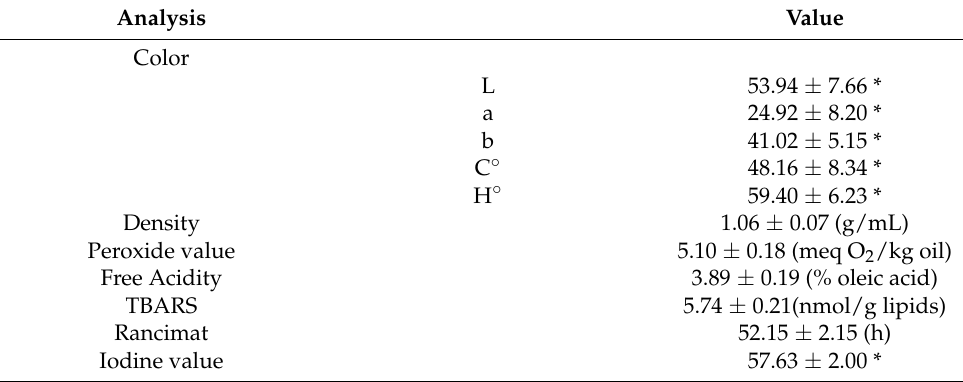
Table 1. Physicochemical characterization of Mayten tree seed